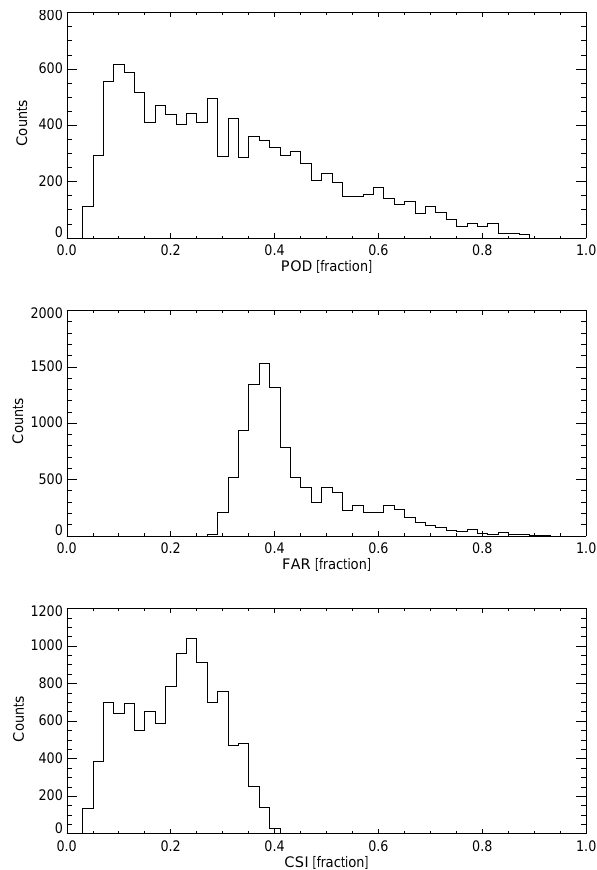
Figure 2. The MSG-CPP parameter threshold settings were varied as follows: 100<CWP<1000 with steps of 100gm − 2 ; 225<CTT<275 with steps of 5K; 0<COT<100 with steps of 10 (no unit); and the height of the maximum IWC values in the DAR- DAR profile varying between 1 and 9 with steps of